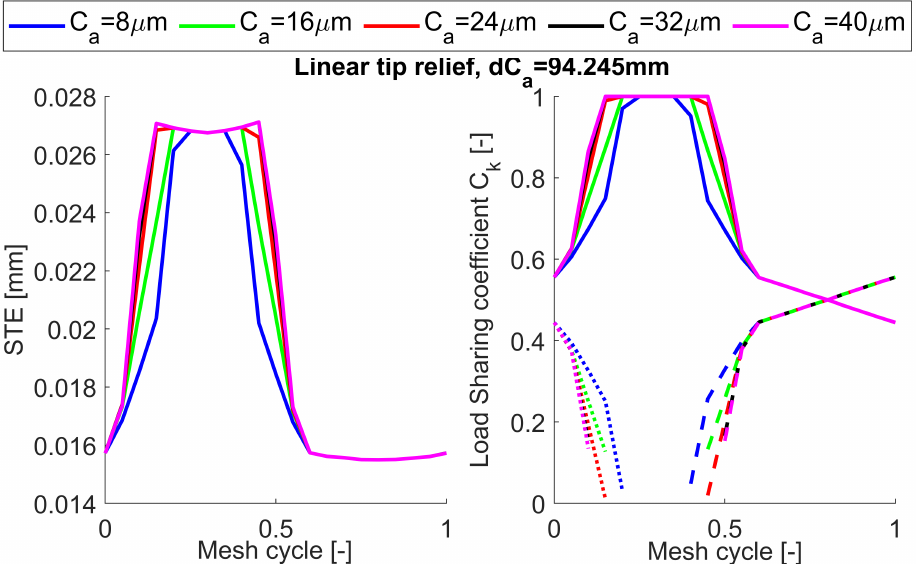
Figure 16. Effect of linear tip relief amount of material removed on the STE and load sharing.